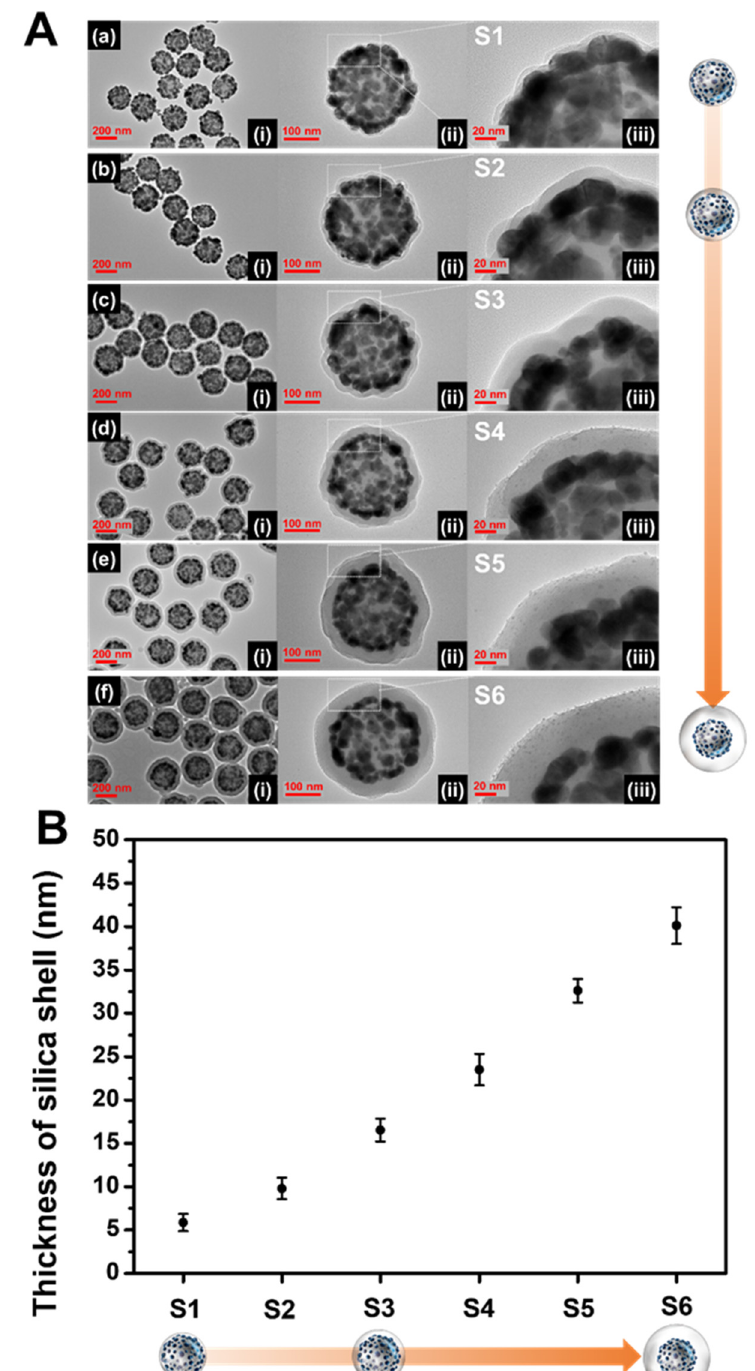
Figure 2. ( A ) TEM images at (i) low and (ii, iii) high magnifications. ( B ) The thickness of the silica shell layer on the surface of the SiO 2 @Ag NPs synthesized under various conditions (a–f). Although the thickness control of the silica shell was successful as described above, reducing the number of SiO 2 @Ag NPs leads to a low yield of the SiO 2 @Ag@SiO 2 product. To generate a thick silica shell coating on the surface of SiO 2 @Ag NPs with a desired and reasonable product yield, a secondary silica shell precursor was added into the suspen- sion of SiO 2 @Ag NPs coated with silica and Na 2 SiO 3 . Tetraethyl orthosilicate (TEOS) was used as a secondary silica shell precursor in the presence of NH 4 OH (as base catalyst in hydrolysis of TEOS). Homogeneous silica shells with variable thickness were grown on